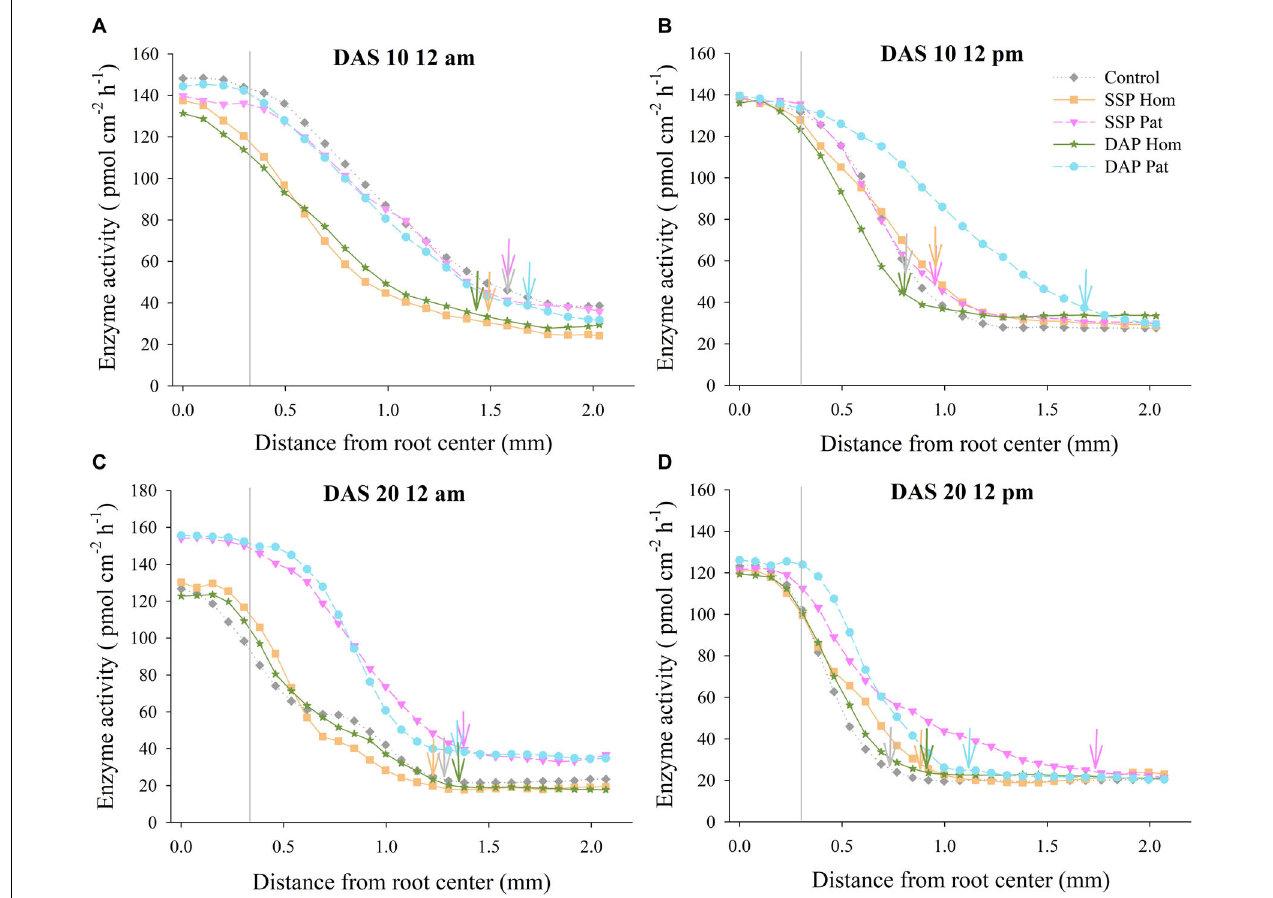
FIGURE 10 | Acid phosphatase activity as a function of distance from root axis to the surrounding soil in P-rich patches. (A–D) represents different sampling time in red soil, respectively. Vertical gray lines refers to average root radius, and vertical arrows represent rhizophere extension for enzyme activity. Each line calculated from four replicates, error bars are omitted to improve